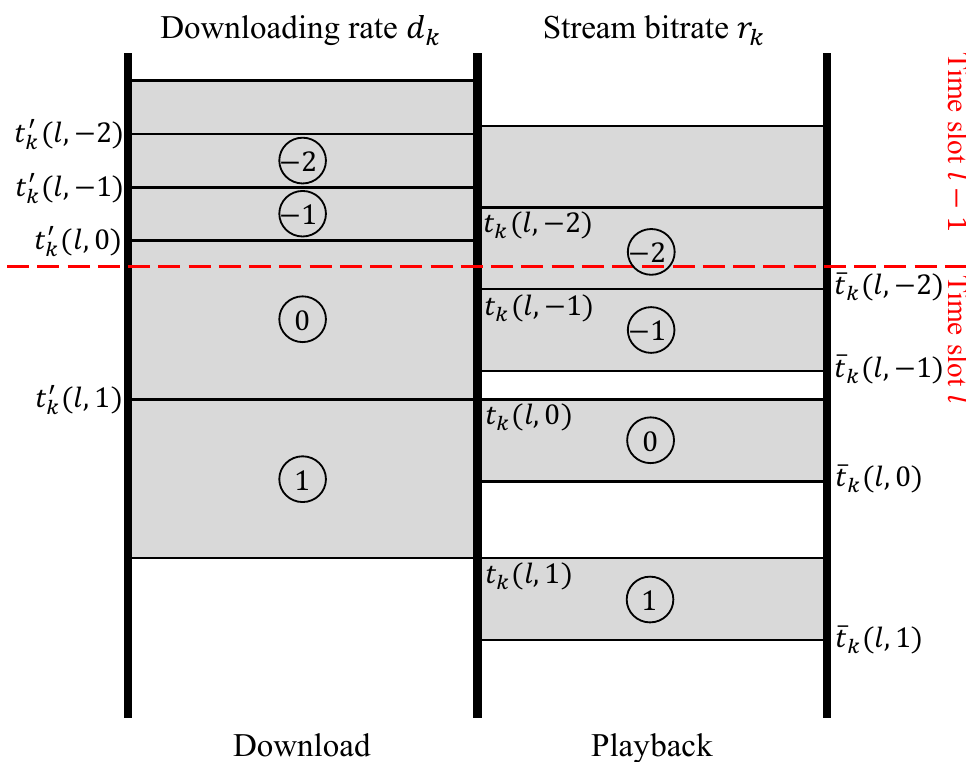
Figure 3. The stall time calculation for users who continue with the video from previous time